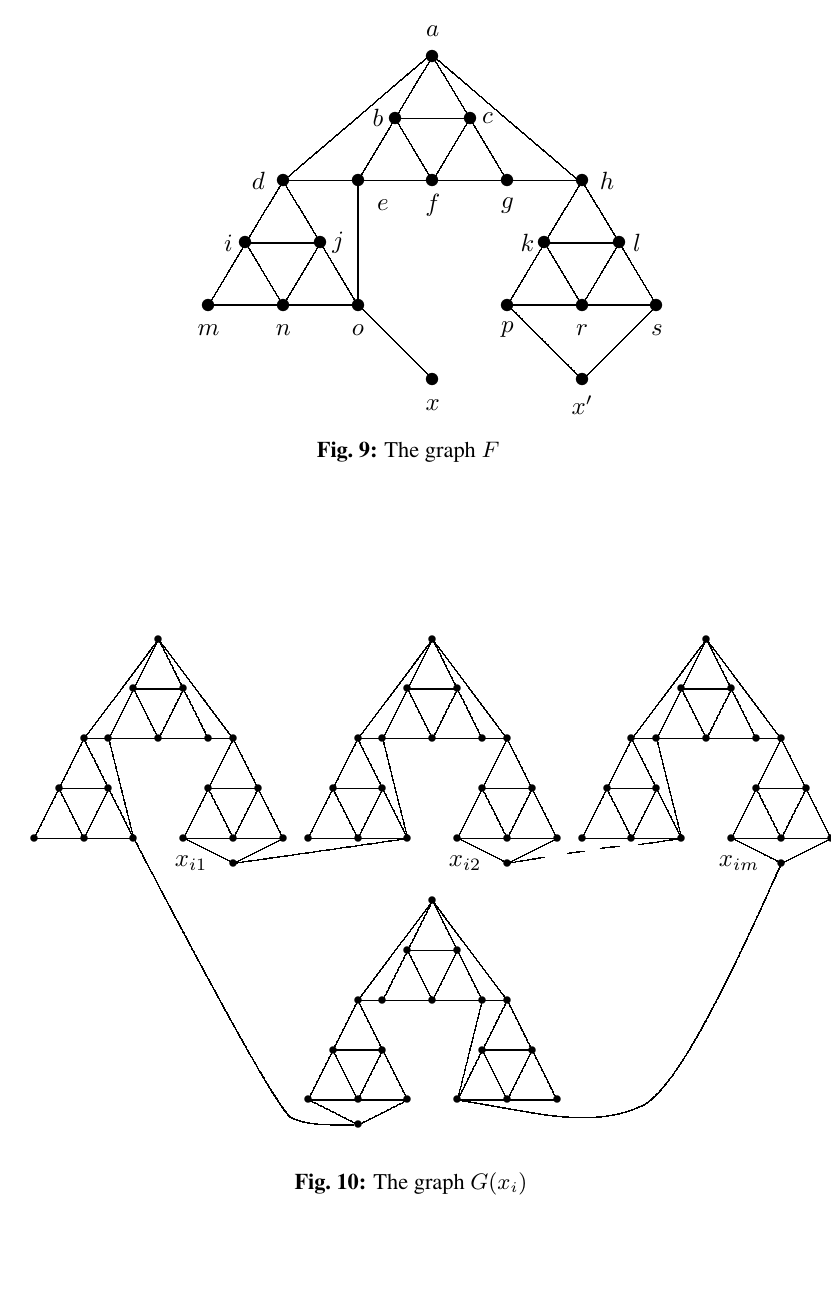
Fig. 10: The graph G ( x i